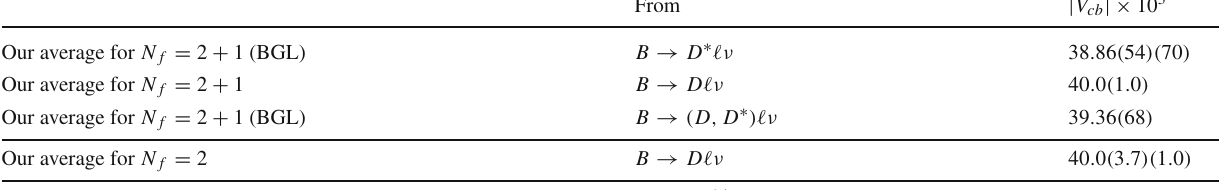
( ∗ ) (cid:6)ν decays [612–615], as well as the inclusive average obtained in the kinetic scheme s